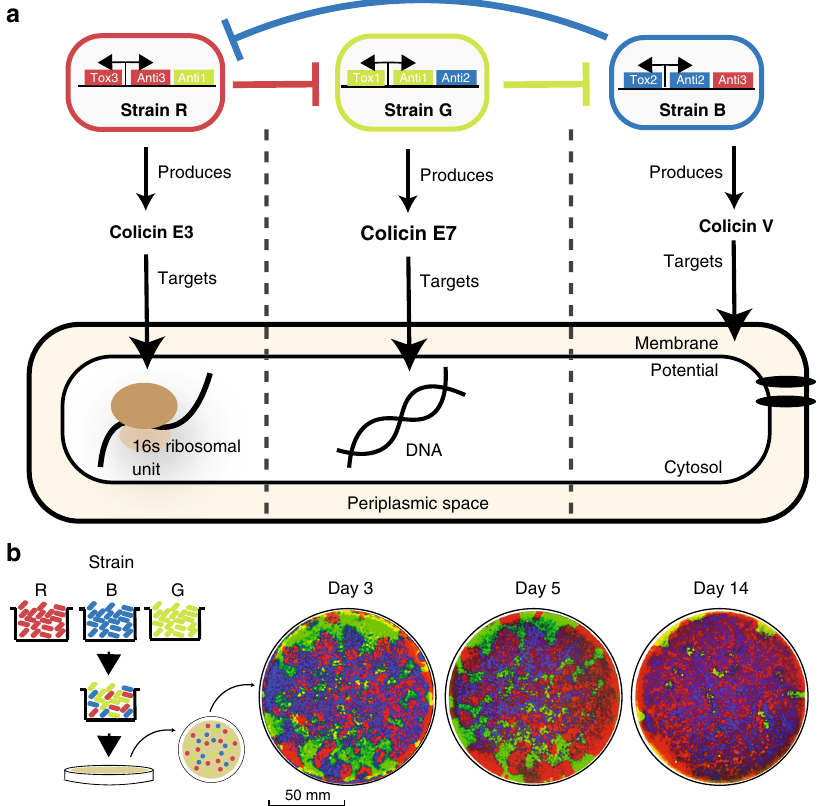
Fig. 1 Cyclic non-transitive dynamics enable biodiversity. a Diagram of the engineered ecology strains including one toxin and two immunity genes. Each toxin produced targets a different essential biological component of E. coli cells. b The three strains were combined at an equal ratio and immediately plated on agar. Each day corresponds to a passage obtained through replica plating. Image stills were obtained by fl uorescence imaging. This experiment was executed one time at this density, but it was repeated at multiple densities as shown in Supplementary Fig.